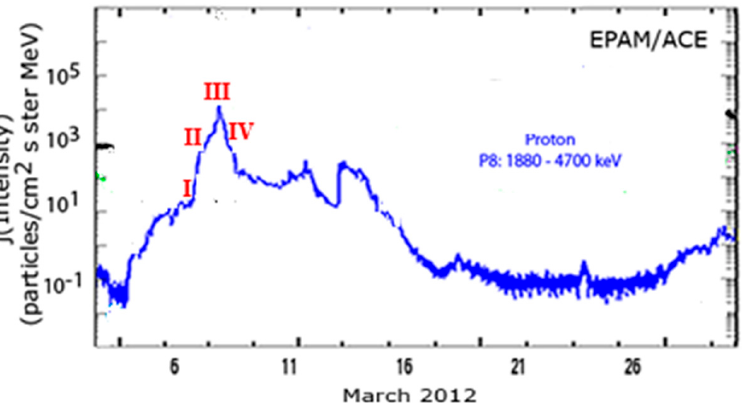
Figure 1. Time profile of energetic protons observed by the ACE spacecraft during 3–31 March 2012. Phases I and II indicate the early and continuing arrival of energetic protons after a flare on 5 March 2012. Phase III shows the proton population related with the corresponding ICME-related IP shock reaching the ACE spacecraft, near Earth, about two days travel into the interplanetary space. After a peak at the time of IP shock arrival, a flux decay is seen due to the departure of the shock front (Phase IV). The SEP described by Phases I–IV, between days 7 and 9 March 2012, is obviously superposed on a longer complex SEP event lasting from 4 March 2012 to ≈ 20 March 2012.